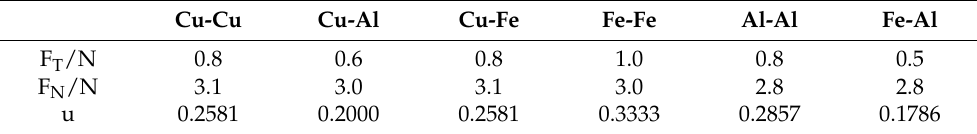
Table 3. The friction coefficient between selected materials.